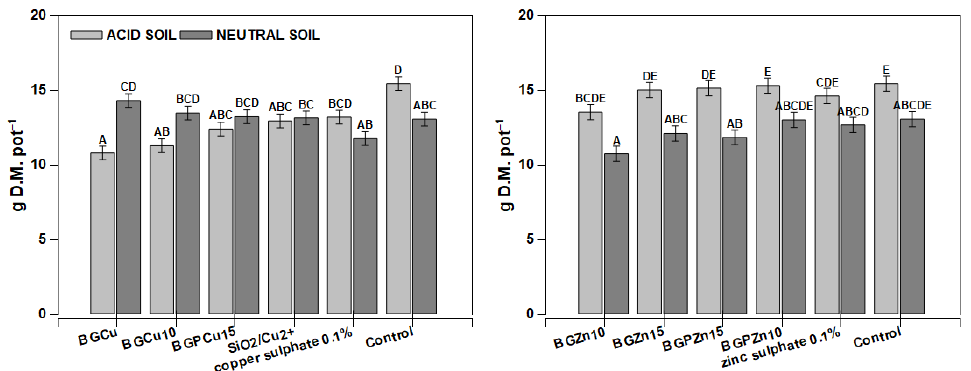
Figure 9. Yields of winter rape Brassica napus L. var napus after foliar application of different fertilizer formulations. Grey bars for acid, dark grey for neutral soil. Bars marked with the same letters represent homogenous groups after Tukey’s test at p < 0.05 and error bars represent standard error (n = 4).